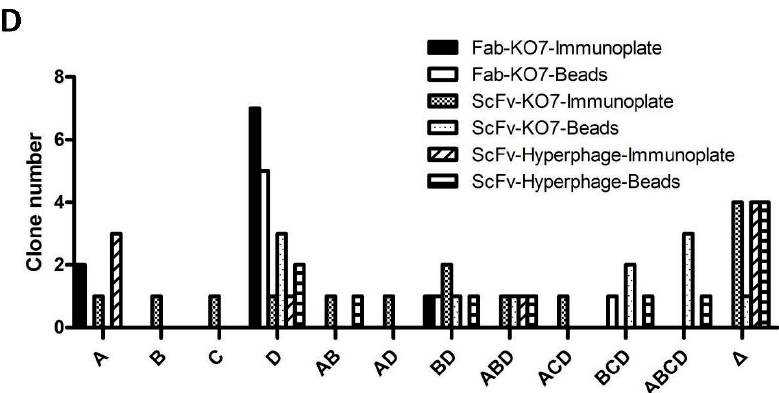
Figure 1. Epitope mapping of isolated antibodies. ( A ) The amino acid sequences of the four epitope clusters on VEGF and the selected residues for alanine-scanning. ( A – D ) Epitope clusters chosen for generating VEGF mutants. The key contact residues (underlined) of VEGF were replaced by alanine. The mutant and the wild type VEGFs were used to map the epitopes; ( B ) The three-dimensional structure of VEGF dimer and the interaction surface with VEGFR2. The VEGF monomers are shown in cyan and gray, respectively. Four clusters ( A – D ) of the receptor binding surface are colored in brown, green, purple, and blue, respectively. Clusters A and C are located on one monomer (cyan) and the clusters B and C are located on the other one (gray); ( C ) The Avastin binding to four VEGF mutants. Various concentrations of Avastin bound to mutant 1, mutant 2, mutant 3, and mutant 4, and the kinetics against these VEGF variants were determined by ELISA. OD, optical density; ( D ) The analysis of the number of isolated clones by different selection strategies and their VEGF epitope clusters.